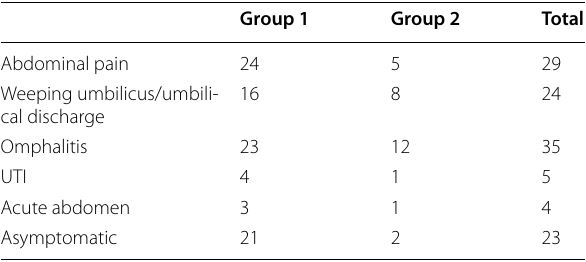
Table 1 Different kinds of symptoms revealed in operated patients Group 1